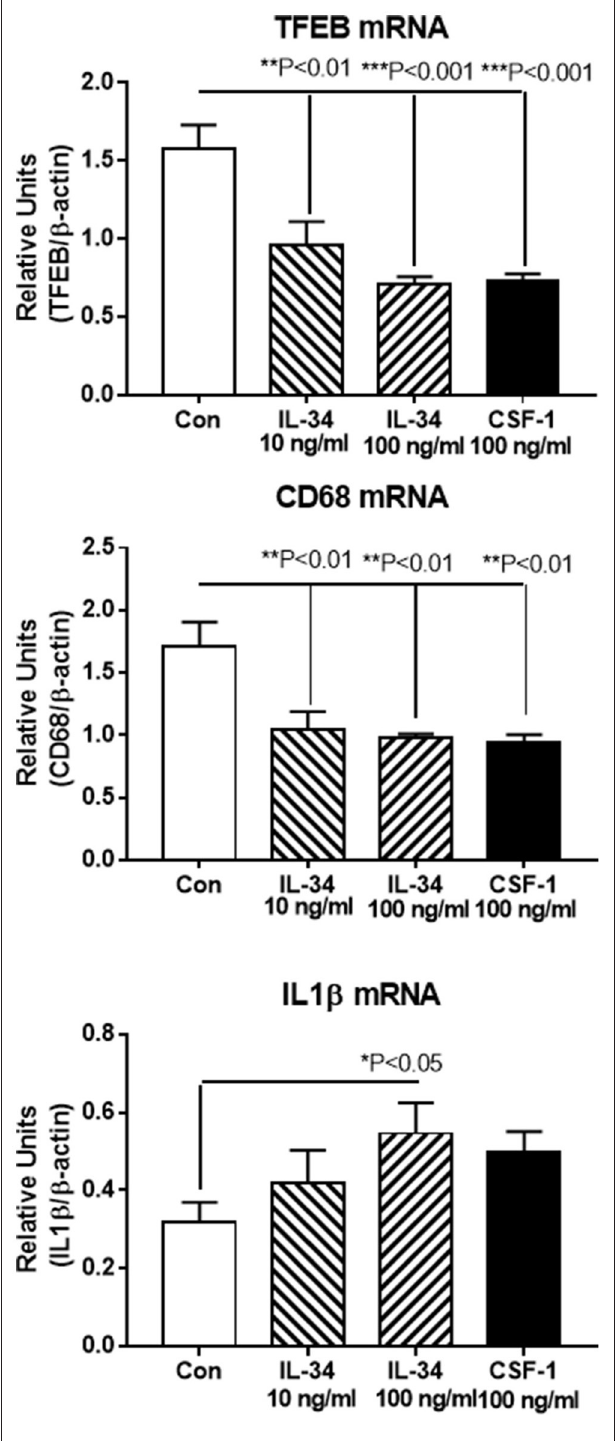
FIGURE 6 | Real time PCR validation of key genes showing similar patterns of upregulation or downregulation as revealed by RNA sequencing data. Transcription factor EB (TFEB) and CD68 are both lysosomal-associated genes involved in A β phagocytosis and metabolism. IL-1 β is a classical proinflammatory cytokine. Results represent mean ± SEM of triplicate determinations for each indicated treatment. Statistically significant differences with treatments were as